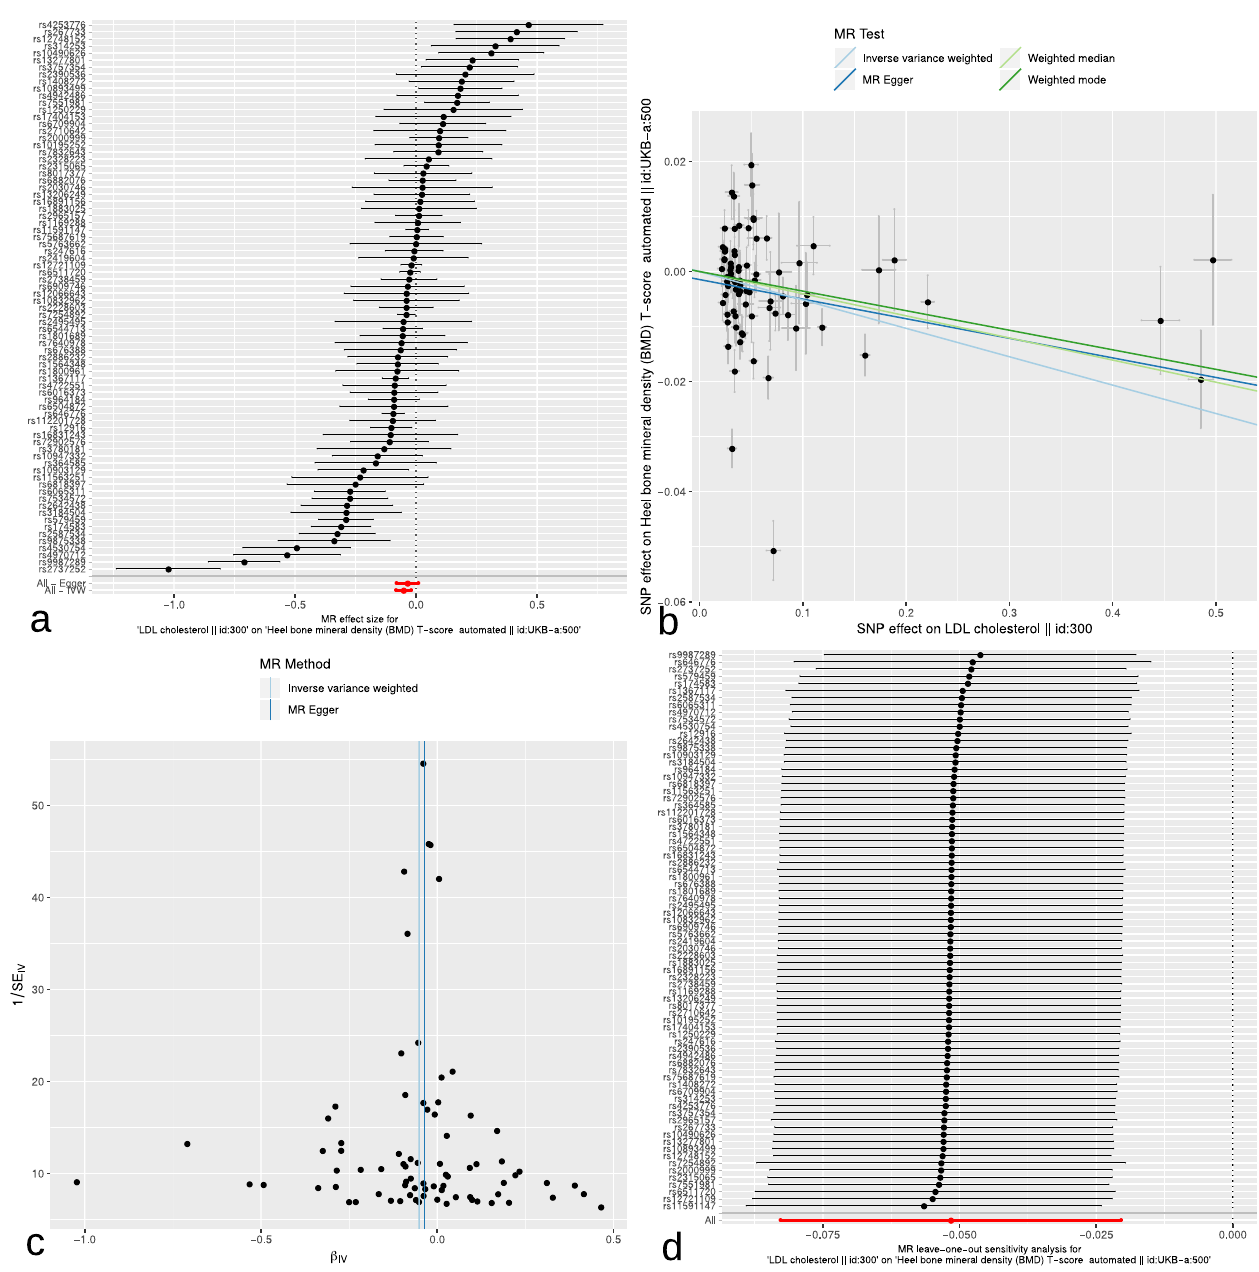
Fig 3. Plots of the MR analysis of the LDL-C exposure predicting total heel BMD outcome. Panel a: forest plot of individual SNP effects, along with 95% confidence intervals. MR-Egger and IVW results are also presented. Panel b: a comparison of the slopes obtained from the various MR methods employed. Panel c: funnel plot showing causal effect of each SNP against the inverse of the standard error of the estimate. The vertical lines show the MR estimates using all SNPs for MR-Egger and IVW methods. Panel d: leave-one-out sensitivity analysis, using the IVW method, along with IVW overall result in red. The relative symmetry of the funnel plot suggests a lower risk of horizontal pleiotropy leading to unreliable associations, as does the MR-Egger intercept. Finally, panel d presents the results of a leave-one-out sensitivity analysis, using the IVW method, and suggests no major outliers were present.